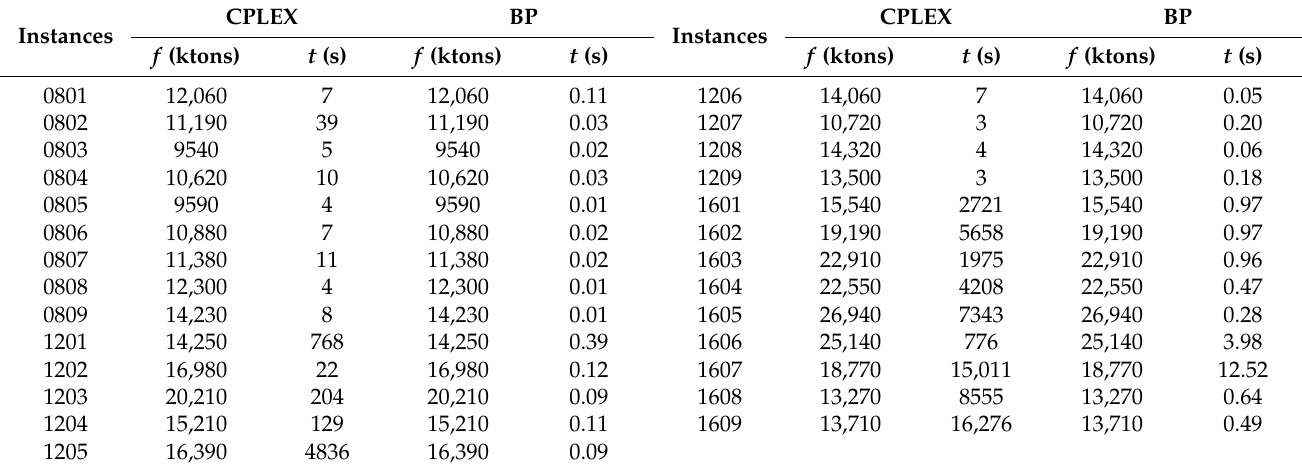
Table 1. Comparison results of BP and CPLEX solving P 1 for 8–16 scale instances.